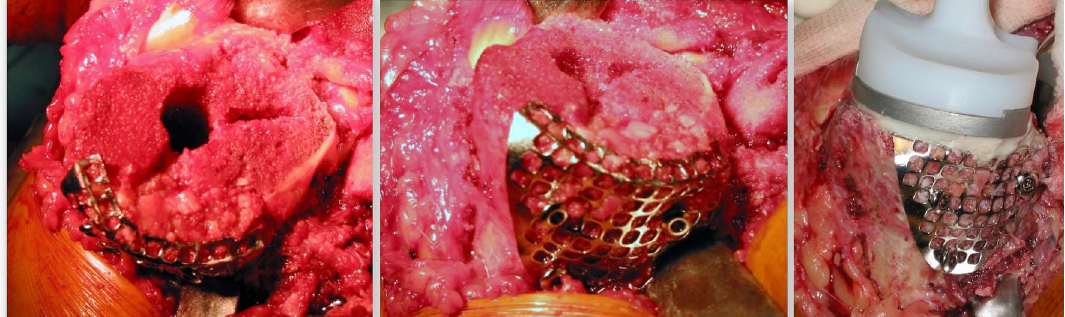
Figure 3. Intra-op images showing reconstruction of tibial defect with wire mesh and impacted bone